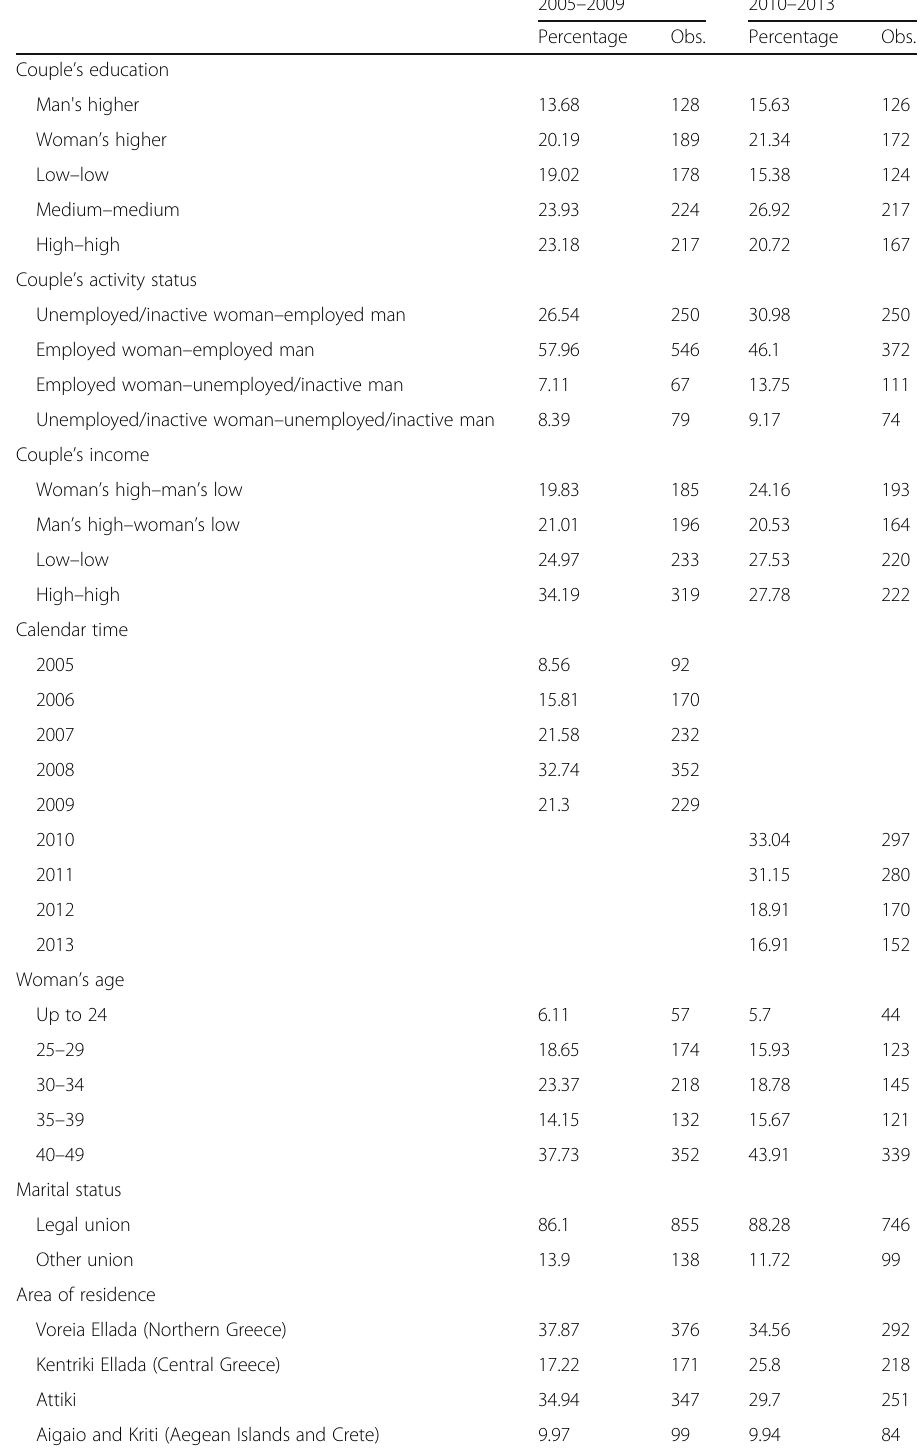
Table 3 Descriptive statistics for the variables used in the study according to time period (2005